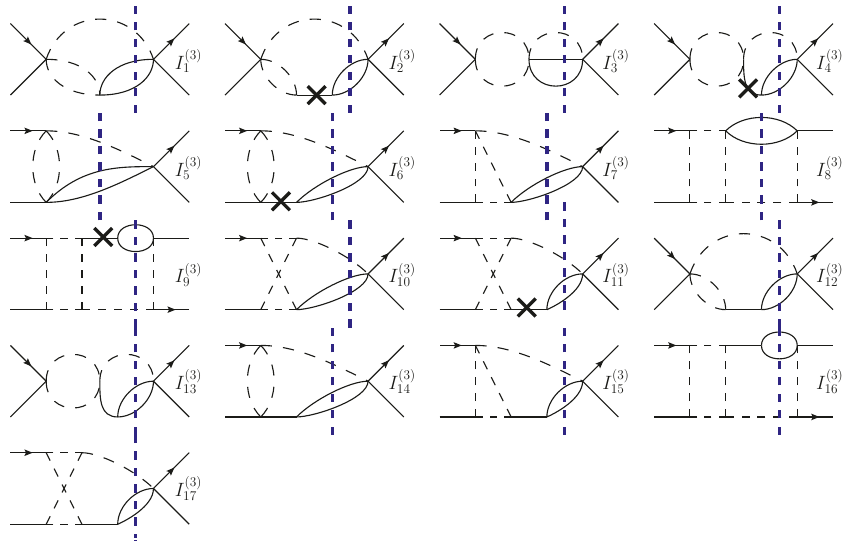
Figure 8 . Three-loop three-particle cut master integrals. Solid and dashed lines denote massive and massless lines, respectively. The blue dashed line symbolizes the cut and crosses denote propagators raised to negative